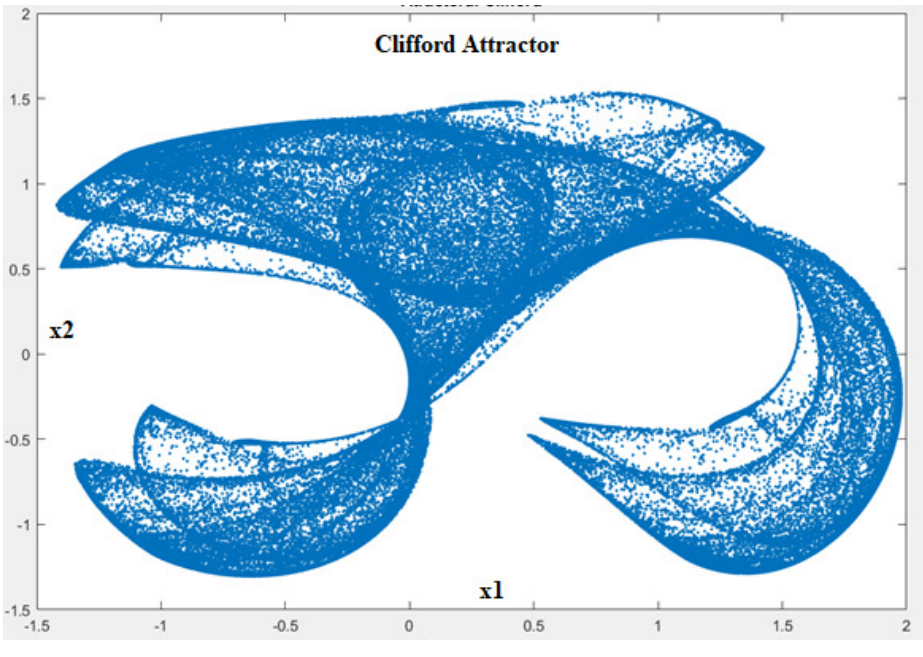
Figure 1. The Clifford